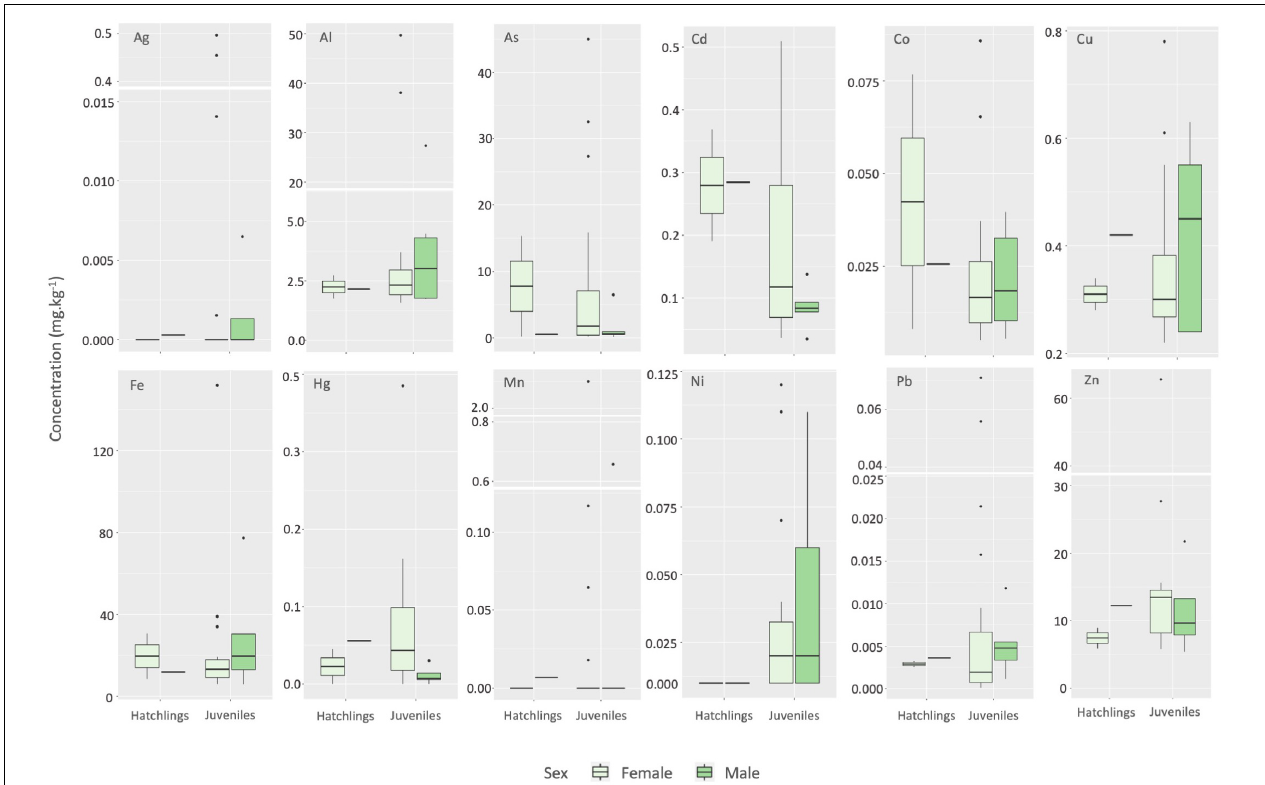
FIGURE 3 | Box plots representing elemental concentration variations in green turtle ( Chelonia mydas ) muscle tissue. Black dots indicate outliers, while white bars represent breaks in the y -axis. Light green columns represent females and dark green,